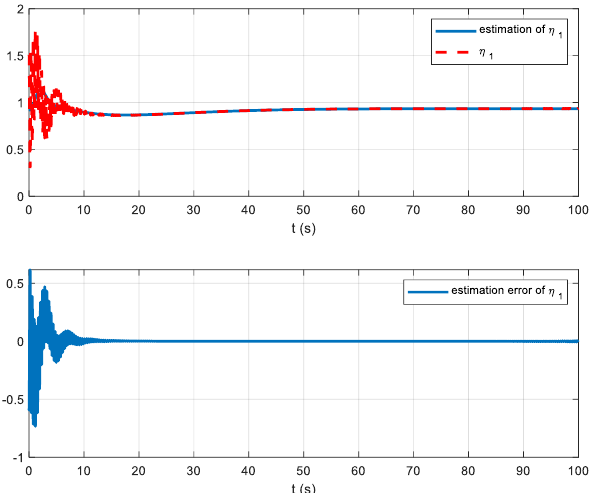
 and its estimation. Figure 4. 1 Figure 4. η 1 and its estimation.